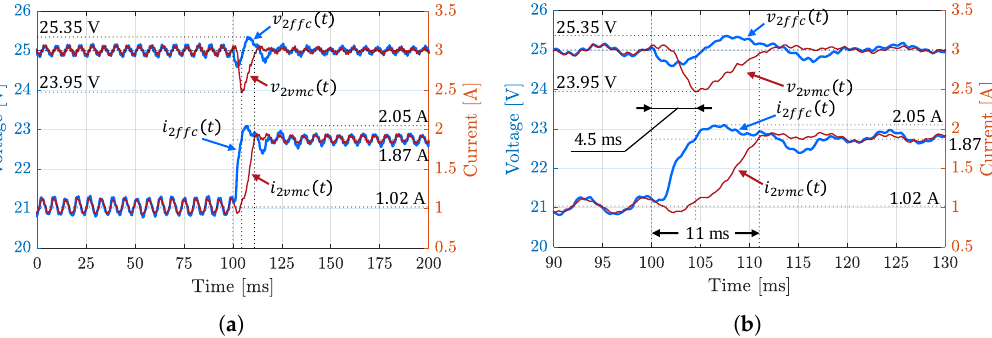
Figure 13. Experimental voltage and current responses: load increases. ( a ) full-time scale; ( b ) zoomed-in view of the transient period.